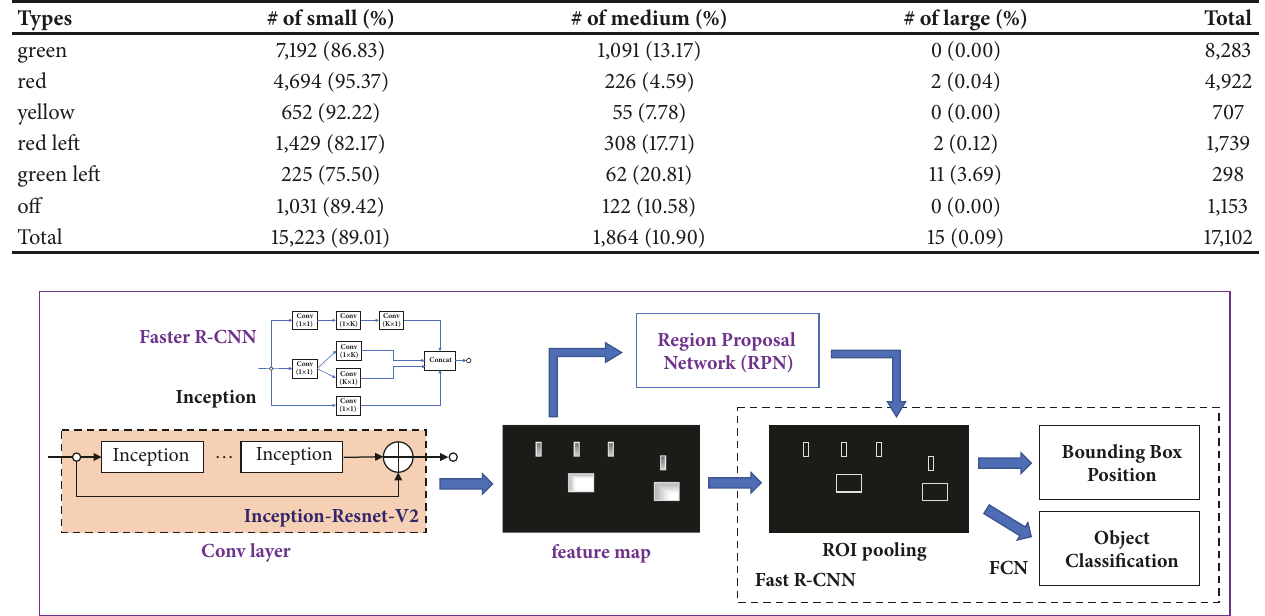
Figure 2: Block diagram of Faster R-CNN network model with Inception-Resnet-v2.